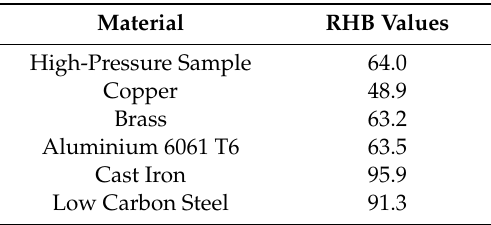
Table 5. Comparison of hardness values of phenol-furfural resin/organo modified MMT clay based high-pressure composite on RHB Scale.